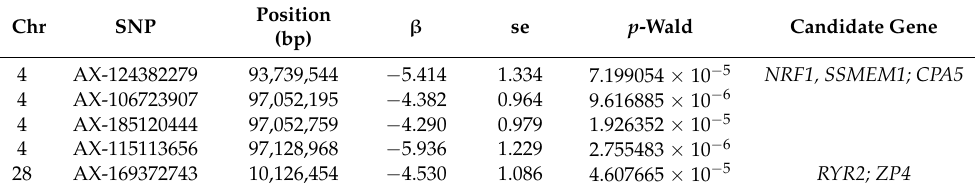
Table 7. List of SNPs associated with reproductive efficiency and candidate genes related to fertility in Retinta beef cattle.